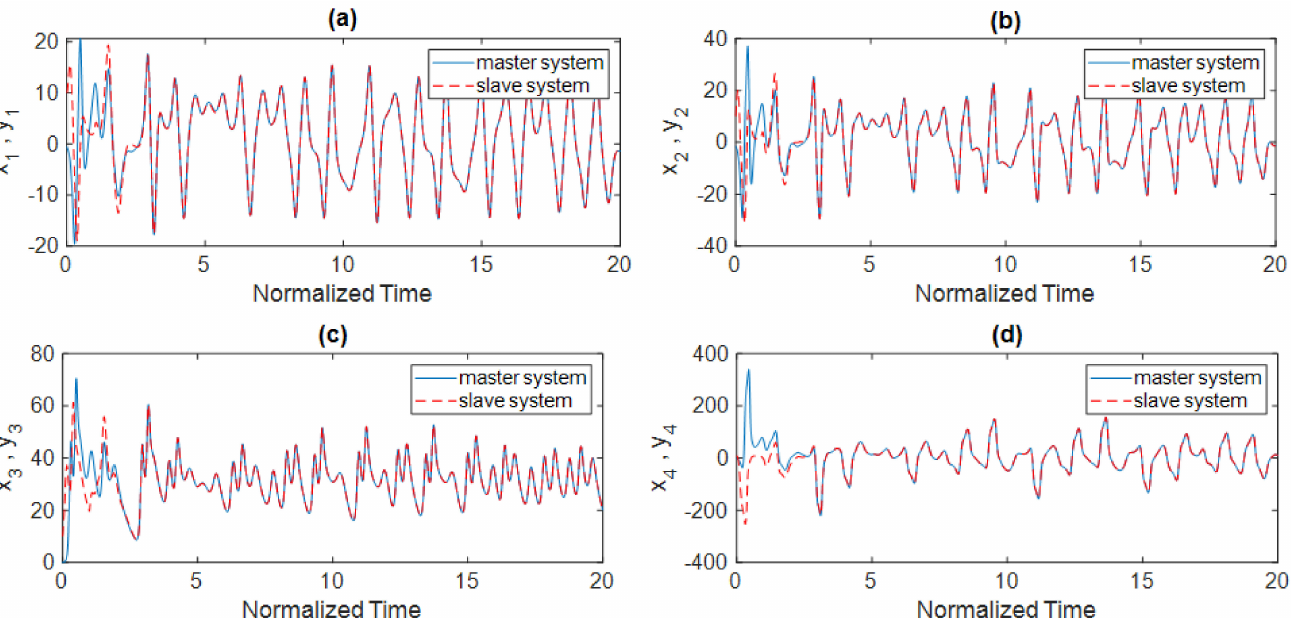
Figure 5. Synchronization results based on the offered control methodology where there are bias faults. Time history of ( a ) x_1 and y_1, ( b ) x_2 and y_2, ( c ) x_3 and y_3, ( d ) x_4 and y_4.